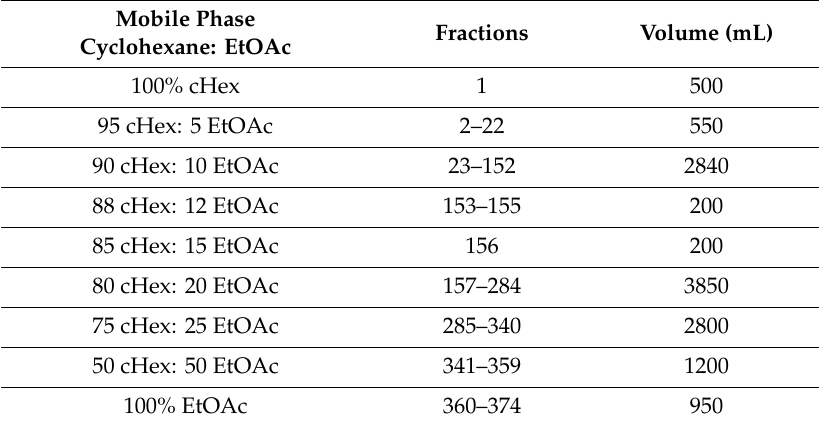
Table 1. Elution systems and fractions for the isolation of